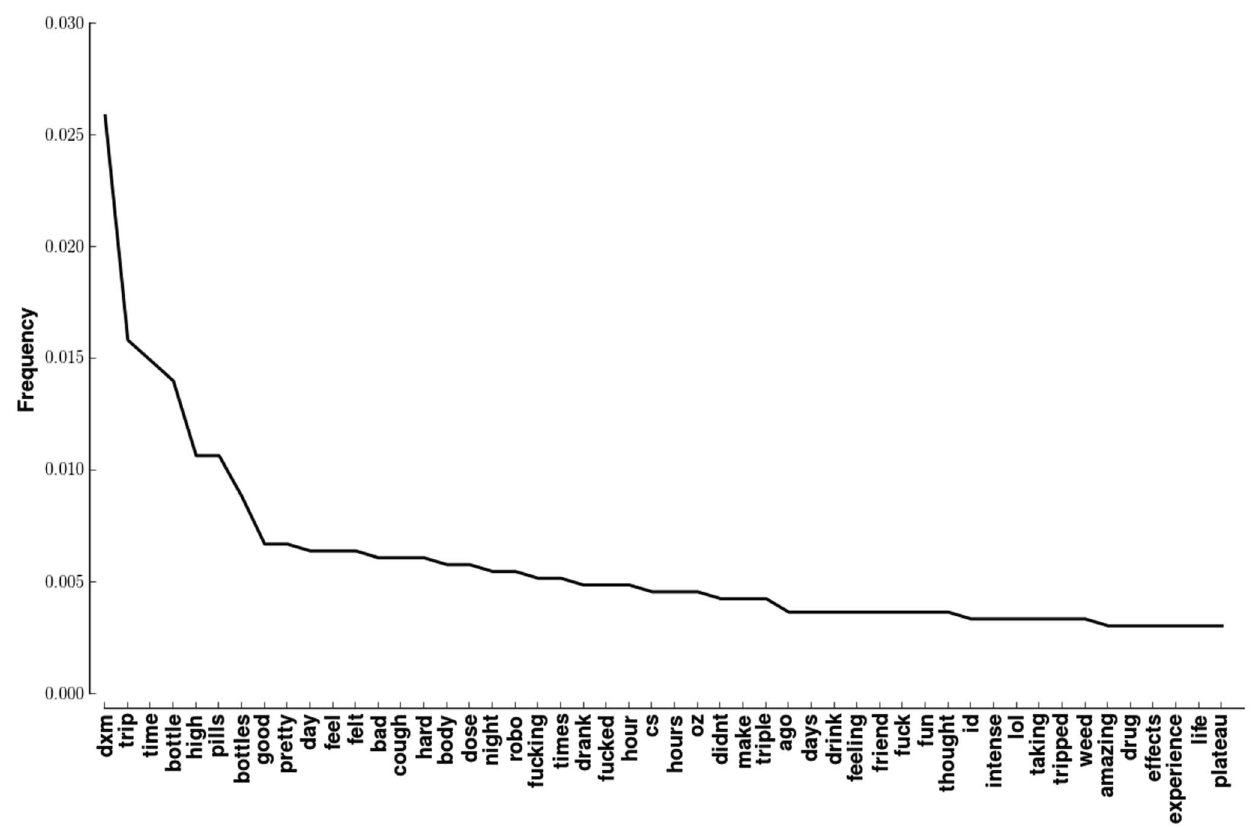
Figure 4. Most frequent words in YouTube comments. Probability density function of words from all YouTube comments analyzed in this paper. The frequency of occurrence was calculated after removing stopwords.